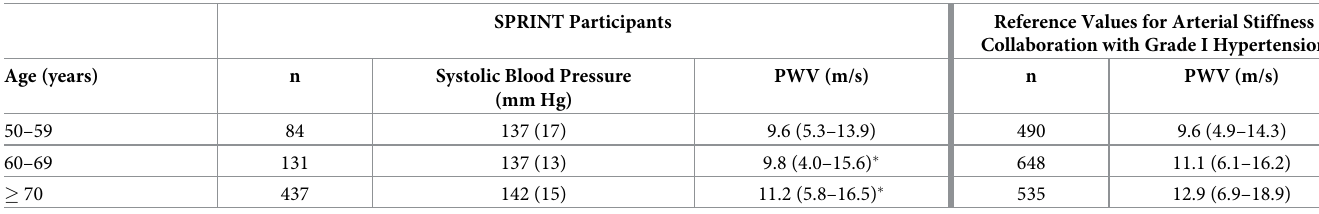
Table 2. Pulse wave velocity and systolic blood pressures by age group in SPRINT cohort and reference populations with grade i hypertension ( (cid:21) 140/90 and (cid:20) 160/ 100 mm Hg)[17].